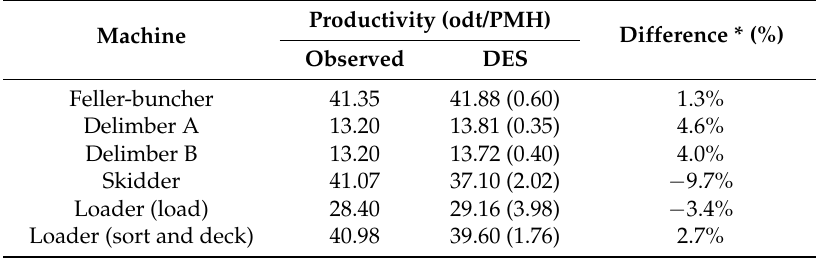
Table 8. Comparison of the estimated mean machine productivities obtained from the LS DES model with the field-observed productivities for lop-and-scatter.